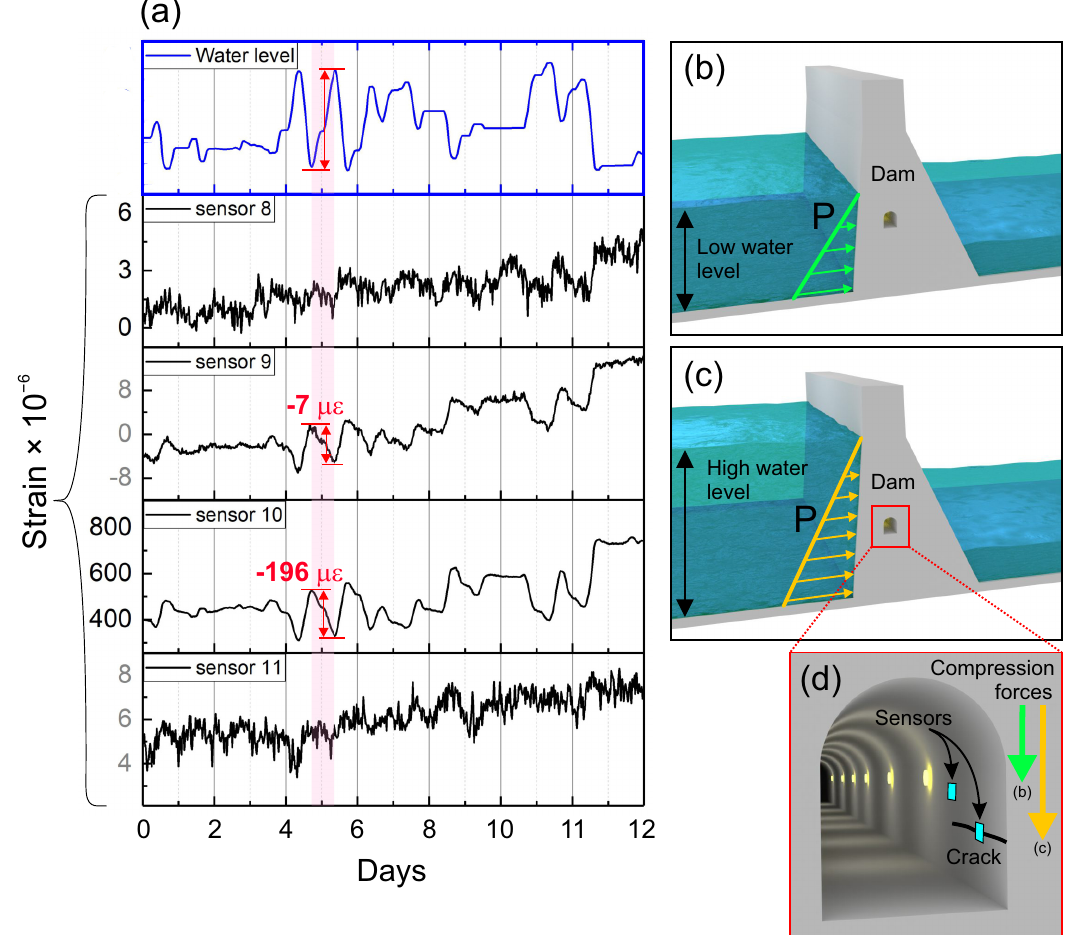
Figure 6. ( a ) Comparison of the measured static strain variations with recorded water level changes that were provided by the dam operator. For comparison, data from sensors 8, 9, 10, and 11 (in the same column) were selected to show the magnitude of strain variations on the crack and away from it. The water stored on the dam always exerts some pressure on the dam construction, regardless of ( b ) low or ( c ) high water level. ( d ) Illustration demonstrating the location of sensors installed on the wall of the gallery. The pressure acting on the dam causes compression forces on the crack, the magnitude of which depended on the level of water in the